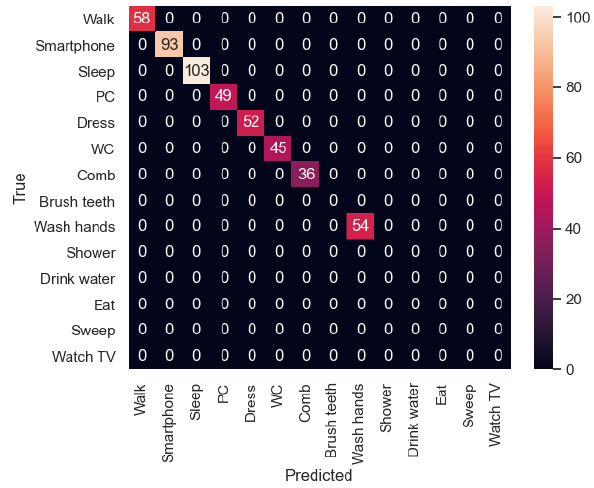
Figure 23. Sequence 1-Experiment 1-Confusion Matrix.